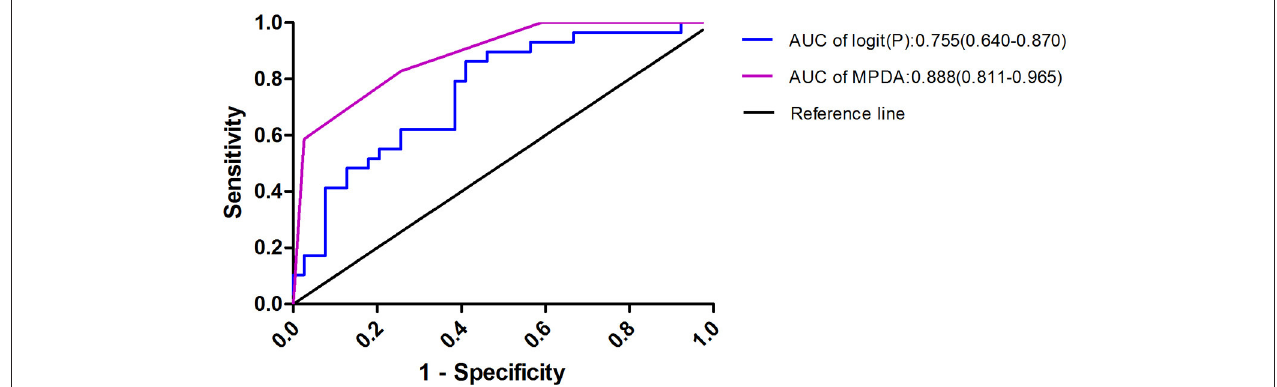
FIGURE 2 | Risk factors were used to produce the receiver operating characteristic curves logit(P) = 1.717 × Male + 3,531 × PLT + 2.421 × D-dimer + 1.583 × APTT; MPDA = 1 × Male + 2 × PLT + 2 × D-dimer + 1 × APTT. When MPDA was more than 2, the predicted sensitivity of APS -PE was 84.6% and the specificity was